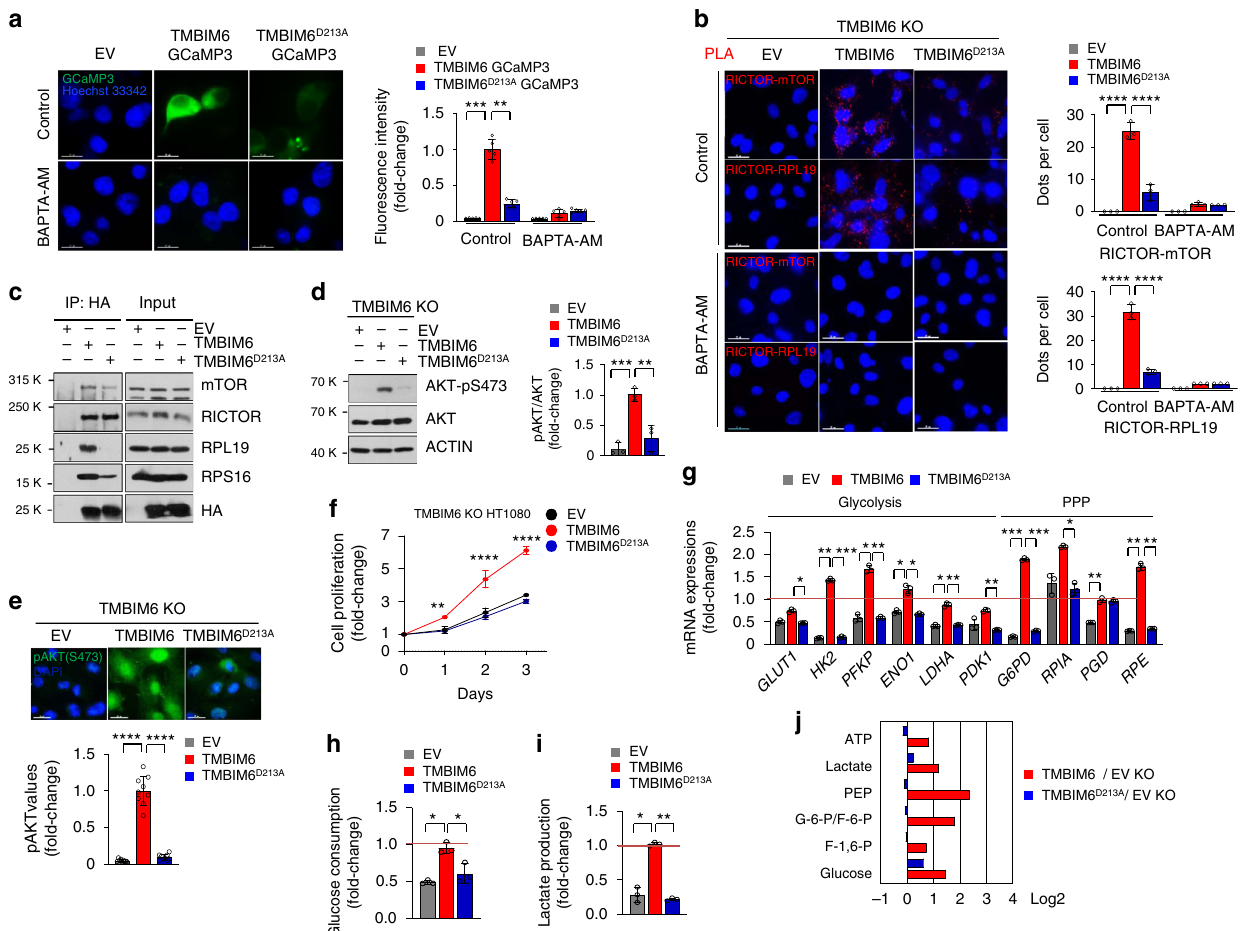
Fig. 6 TMBIM6-induced Ca 2 + leakage affects mTORC2 assembly and the association between mTORC2 and ribosomes. a Immuno fl uorescence images and fl uorescence intensity (right) of TMBIM6-GCaMP3 and TMBIM6 D213A-GCaMP3 in the presence or absence of 10 µ M BAPTA-AM. ( n = 5 independent experiments). Scale bar, 15 μ m. Data are presented as means ± SD. ** p < 0.01, *** p < 0.001, two-way ANOVA followed by Bonferroni ’ s post hoc test. b PLA between Rictor and mTOR or between Rictor and RPL19 (red dots) in empty vector, TMBIM6, or D213A-transfected HT108 cells. ( n = 3 independent experiments). Scale bar, 15 μ m. Data are presented as means ± SD. **** p < 0.0001, two-way ANOVA followed by Bonferroni ’ s post hoc test. c Immunoblot analysis of the immunoprecipitates with Anti-HA antibody and input of cell lysates with the indicated antibodies. d Immunoblotting and quanti fi cation of phosphorylation of AKT in TMBIM6 KO HT1080 cells transfected with empty vector, TMBIM6 WT, and TMBIM6 D213A. ( n =